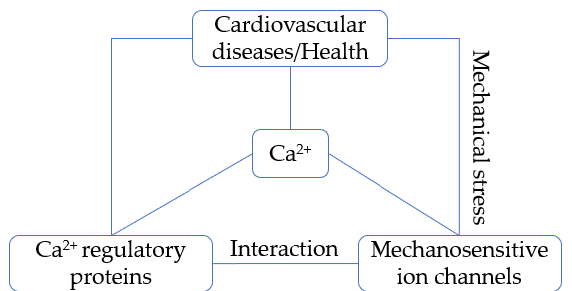
Figure 1. Ca 2+ links Ca 2+ regulatory proteins with mechanosensitive ion channels to regulate cardiovascular health and diseases. The mechanical stress generated in either cardiovascular health or disease directly stimulates mechanosensitive ion channels and induces Ca 2+ entry. Then the Ca 2+ regulatory proteins sensing the changes of Ca 2+ cross-talk to or interact with mechanosensitive ion channels, which contributes to the development of cardiovascular disease or